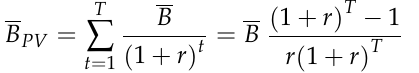
Figure 15. Total loss for three different scenarios.